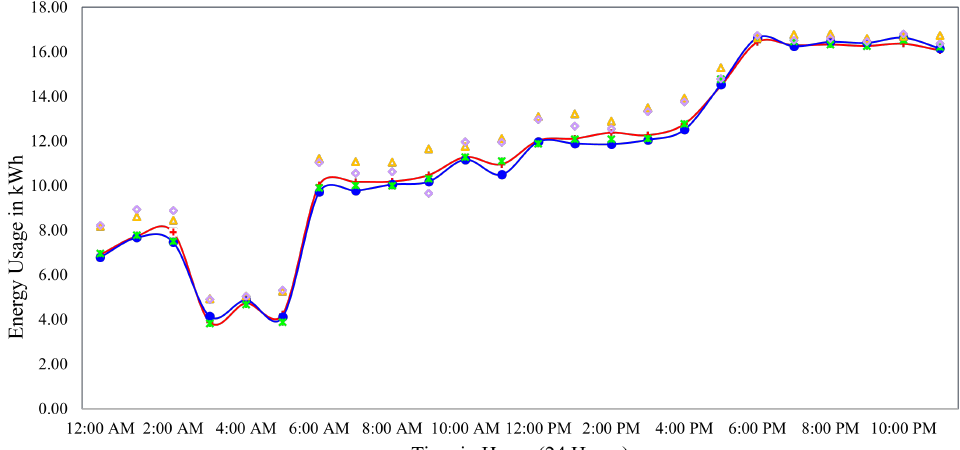
Figure 4. Base station’s typical daily energy usage.